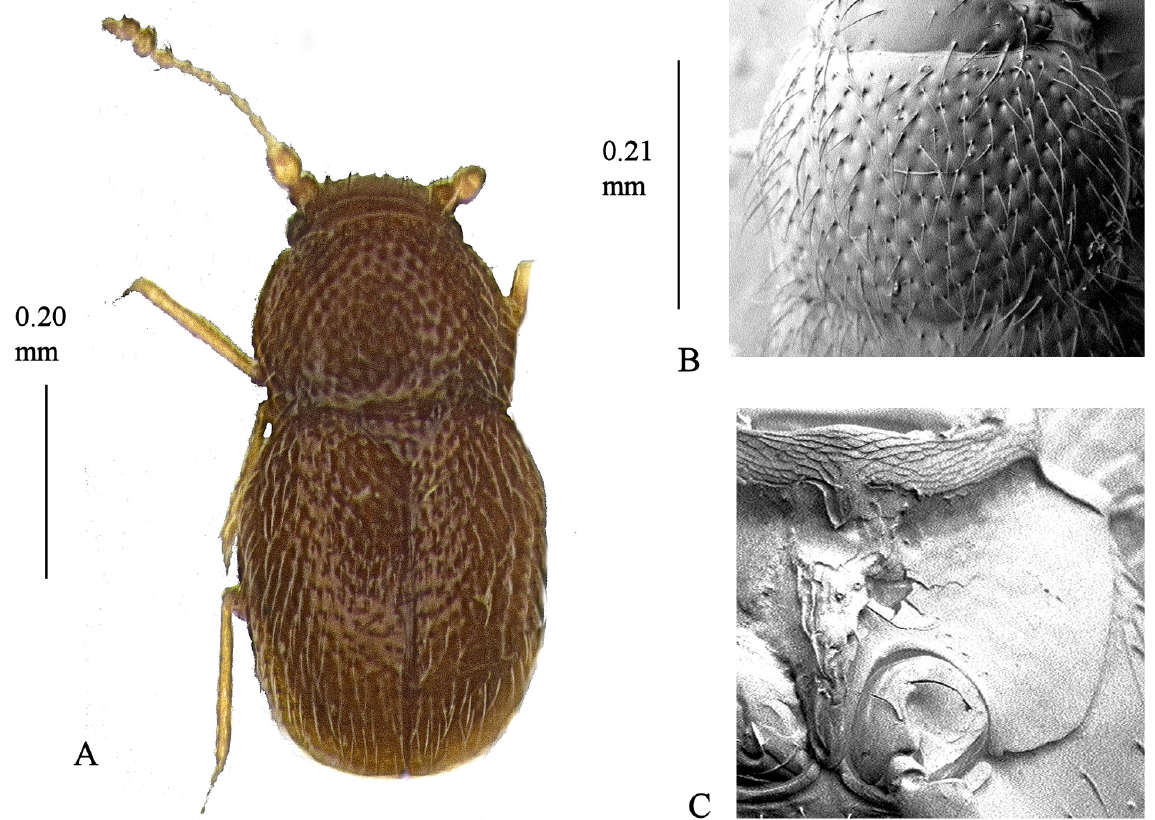
Fig. 51. Cissidium itoi Sawada, 2008. A . Habitus. B . Pronotum, × 375. C . Mesoventrite showing median process of collar, mid keel, keel and lateral margin,